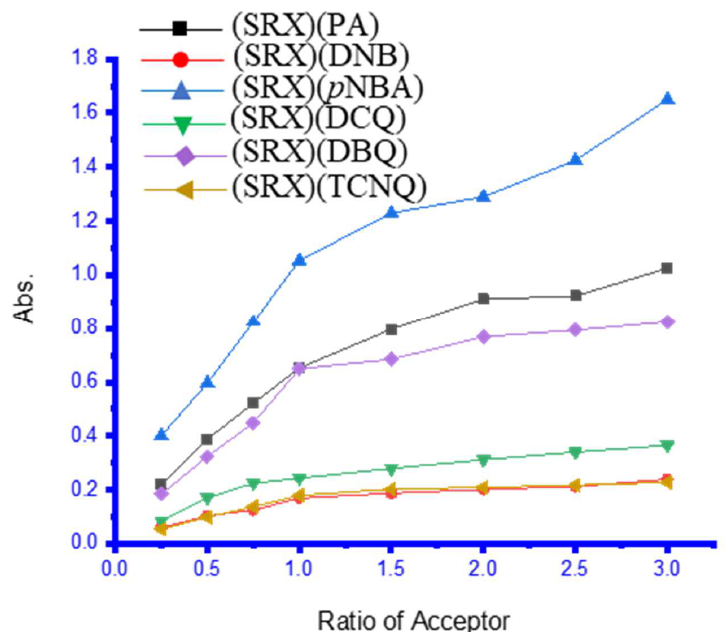
Figure 6. Photometric titration curves of the SRX with the six π –acceptors complex [4].